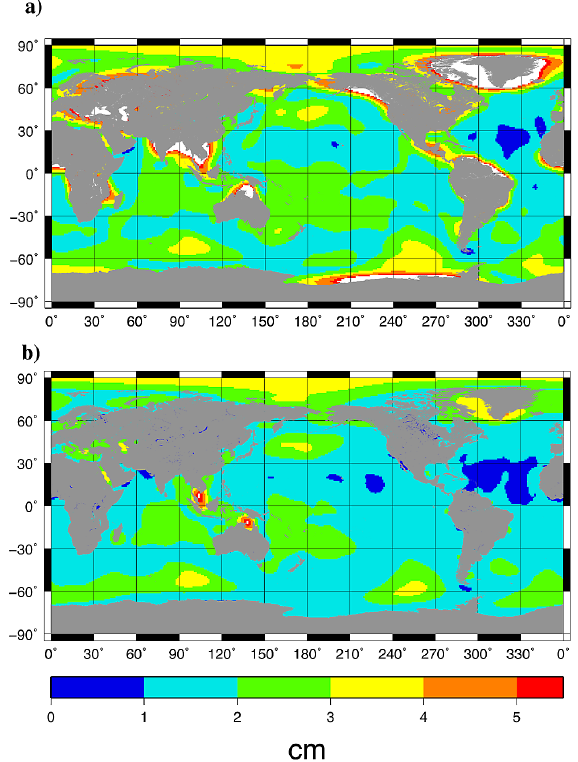
Fig. 2. Standard deviation of OBP from GRACE (CSR RL05) (a) without leakage correction and (b) with leakage